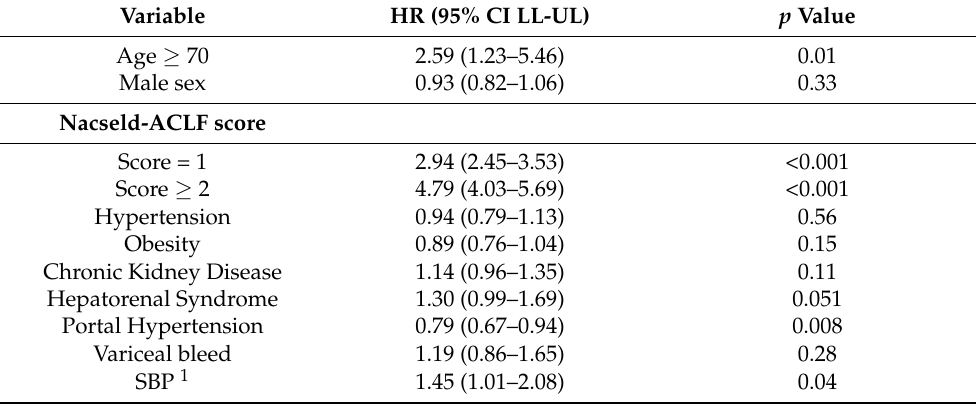
Table 4. Mortality predictors in COVID-19 positive liver cirrhosis (Multivariate